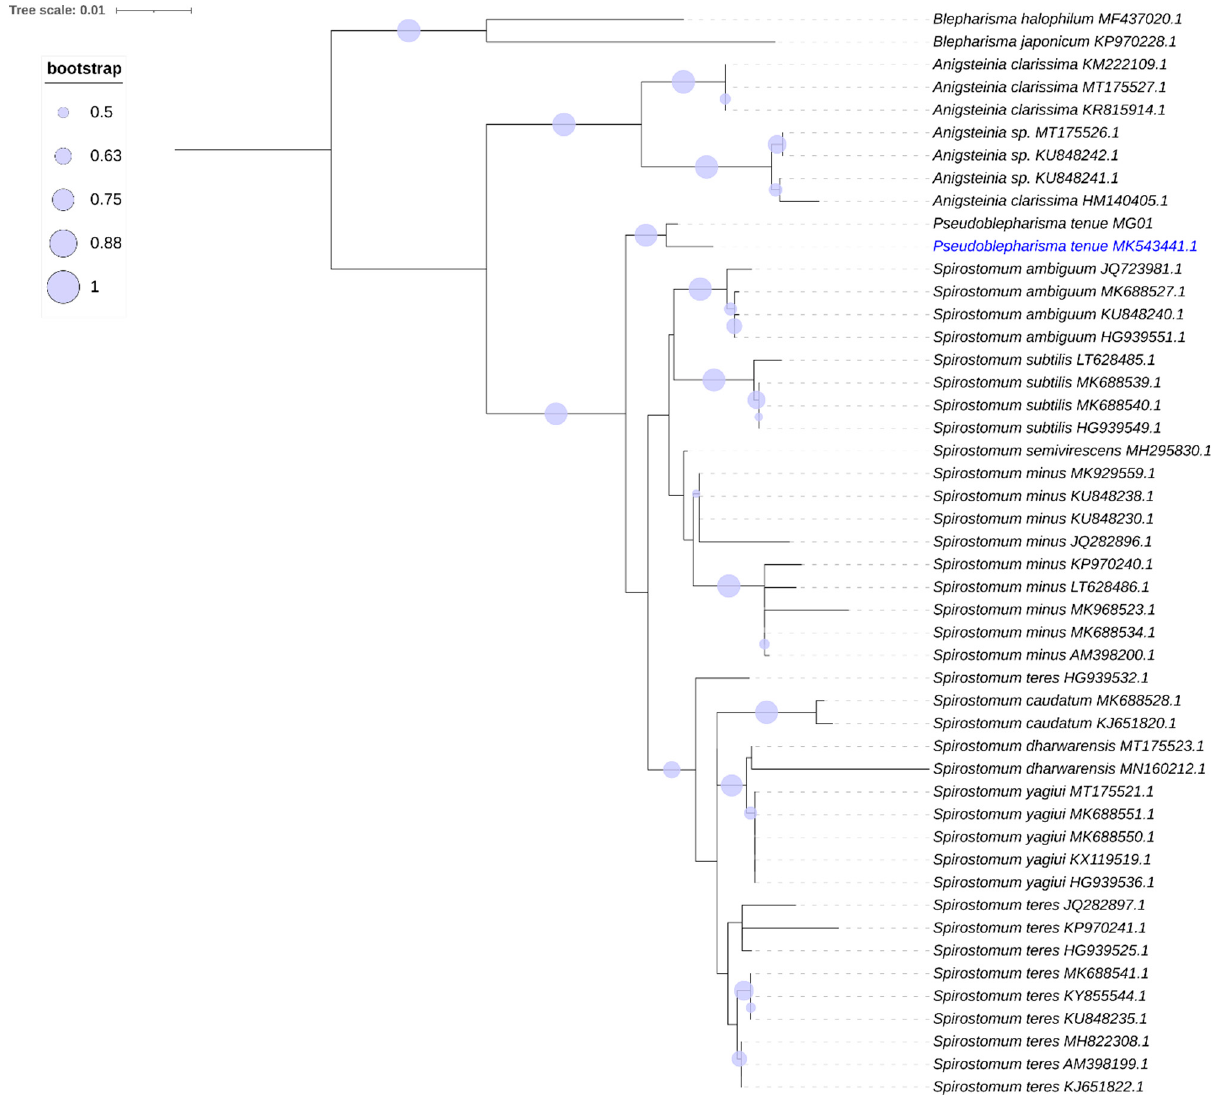
Figure 3. Phylogenetic tree showing Pseudoblepharisma tenue var. viride . Maximum likelihood (ML) tree inferred from SSU rDNA sequences showing the systematic position of Pseudoblepharisma tenue (blue text, MK543441). ML Bootstrap values are indicated by the size of the blue circles. The bar corresponds to 1 substitution per 100